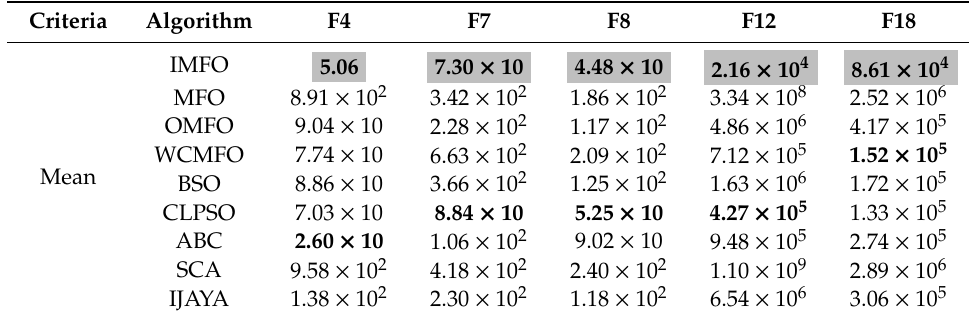
Table 7. Comparisons between IMFO and eight algorithms on five benchmark functions of CEC2017 with 30 dimensions.